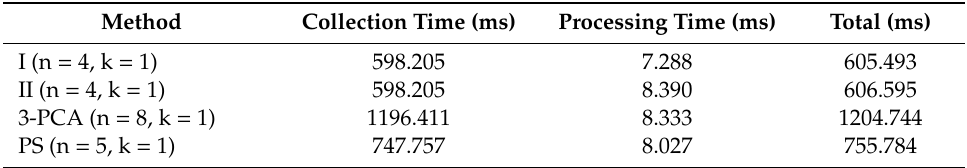
Table 5. Collection time and processing